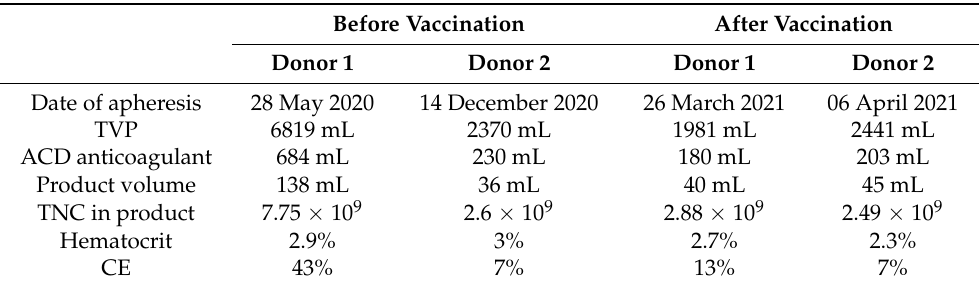
Table 3. Donor apheresis parameters of SARS-CoV-2 convalescent donors before and after receiving the Pfizer-BioNTech vaccine. TVP: total volume processed; ACD: acid-citrate-dextrose; TNC: total nucleated cells; CE: collection efficiency.